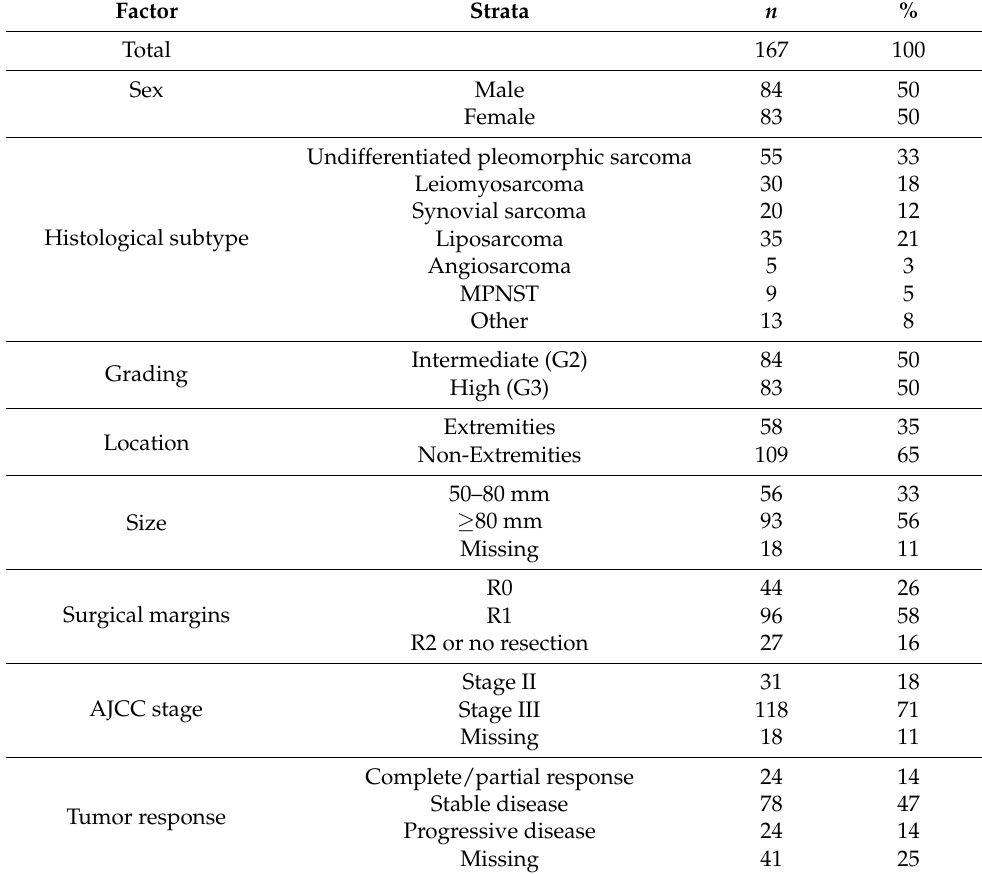
Table 1. Patient